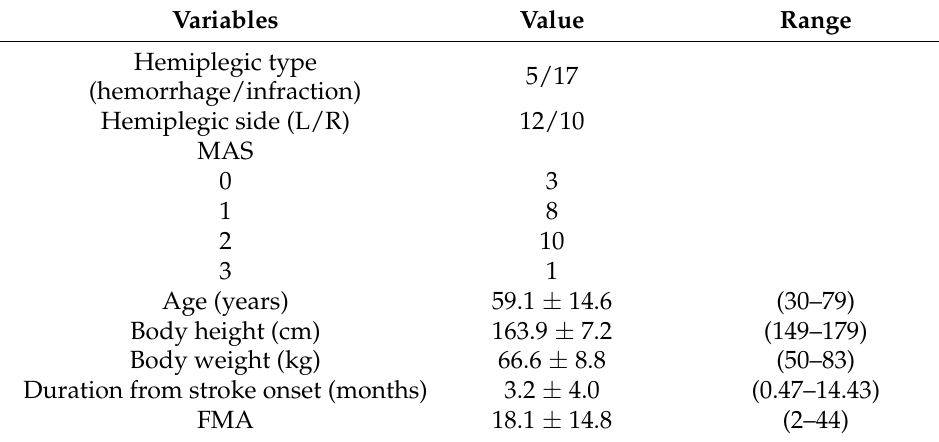
Table 1. Demographic and clinical data of all subjects.